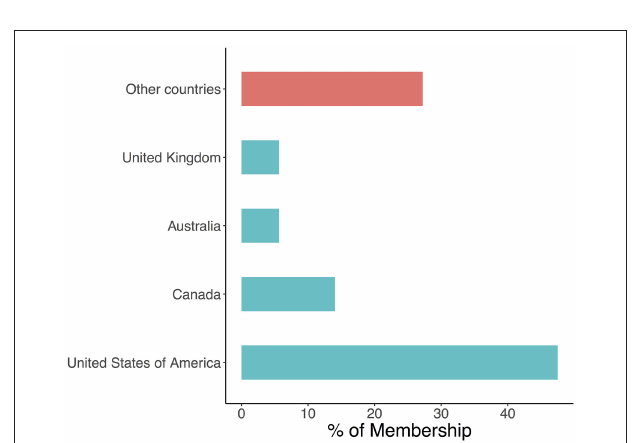
FIGURE 1 | Geographic diversity of members of the Society for Conservation Biology Marine Section in 2016. Bars represent the percentage of members affiliated with institutions based in each country. Almost three quarters of members (73%) were affiliated with institutions based in just four wealthy countries (blue bars). The remaining 27% of members were affiliated with institutions from 64 countries, and most of these countries were represented by fewer than five members (pink